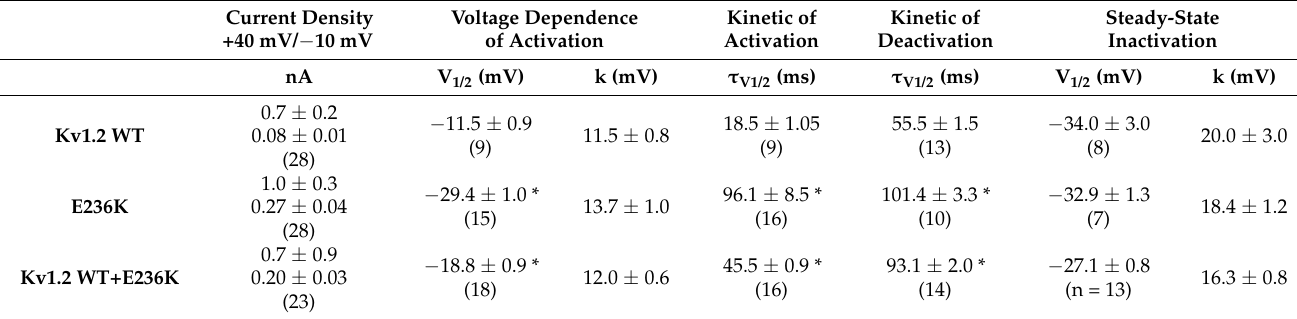
Data are mean ± SEM of the number of cells indicated in parenthesis. * p < 0.05, with respect to